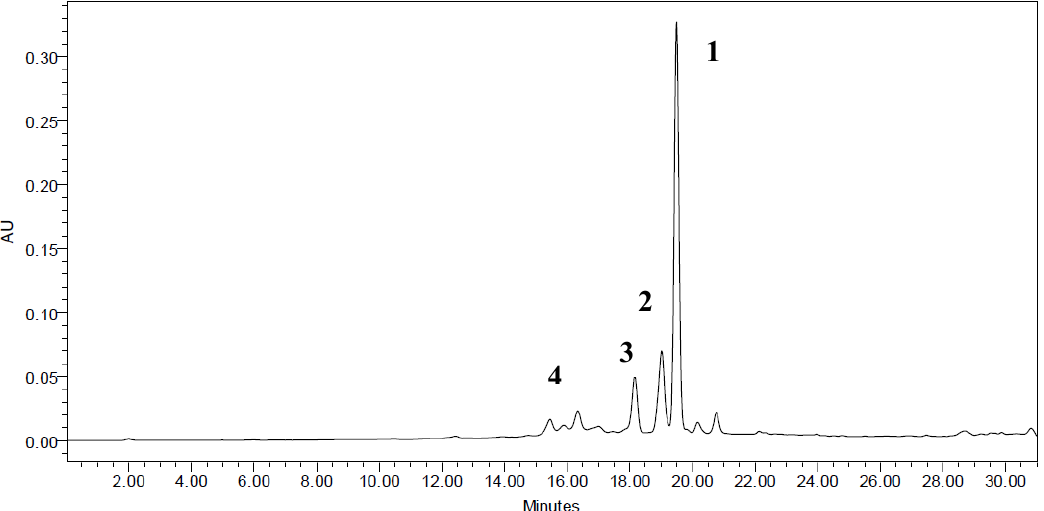
The peak numbers as refer to the identified metabolites as follow: 1, quercetin rhamnoside; 2, quercetin glucoside; 3, rutin; 4, chlorogenic